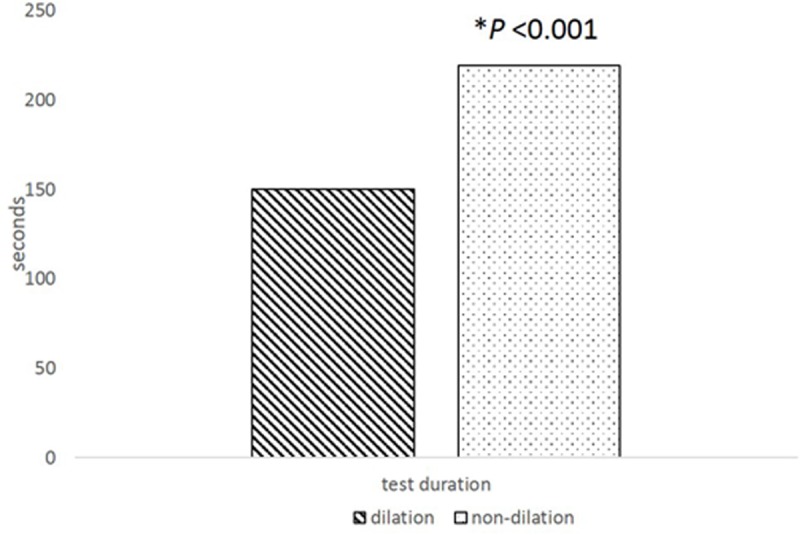
Difference in test duration time (seconds) in dilated and non-dilated settings.(Mann-Whitney U-test, *P<0.05).